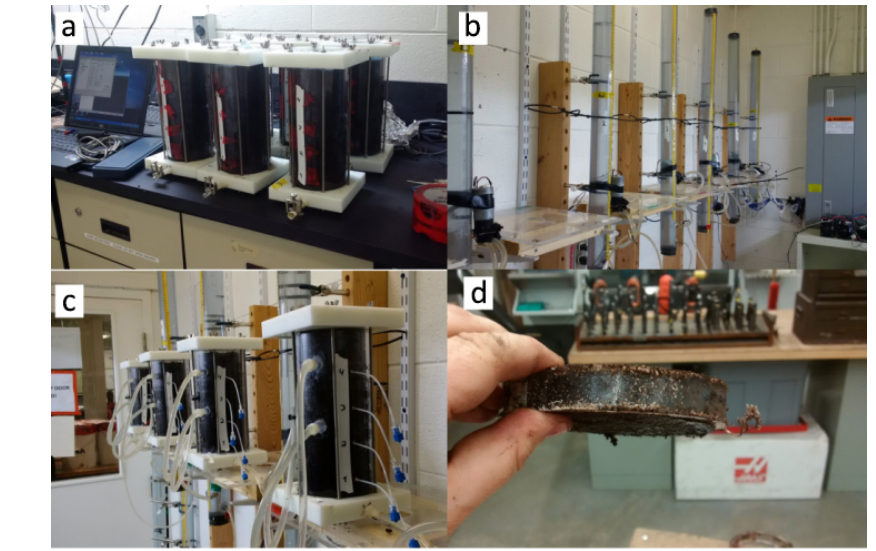
Figure A2. Pictures from the unsaturated transport experiment: (a) columns with peat (note the laptop for scale); (b) Marriot bottles and pumps; (c) columns connected and instrumented (blue caps are the soil pore-water samplers; large tubes are the tensiometers); and (d) slice of a peat column before extraction at the end of the